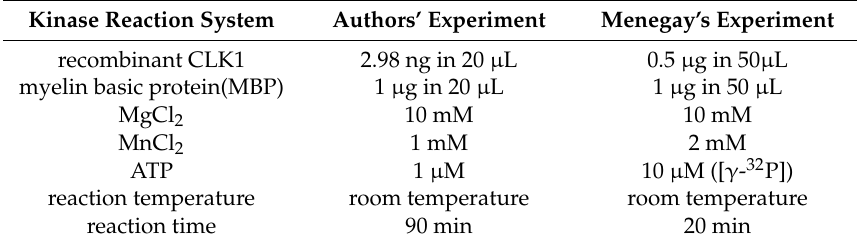
Table 2. Comparison of the kinase reaction components in our experiment with Harry